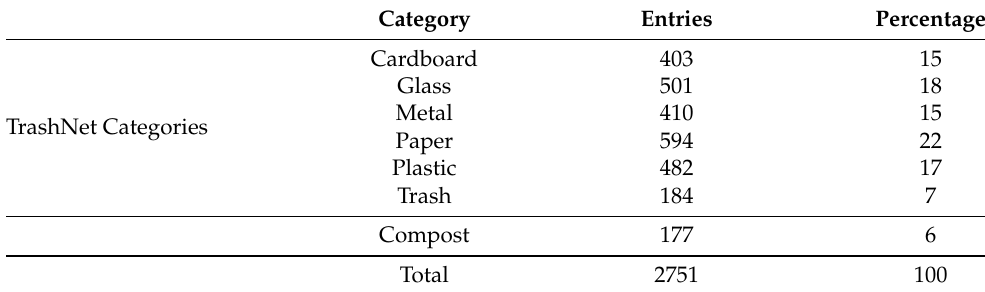
Figure 1. Trashnet dataset, one sample for each class. Table 1. TrashNet and CompostNet Dataset